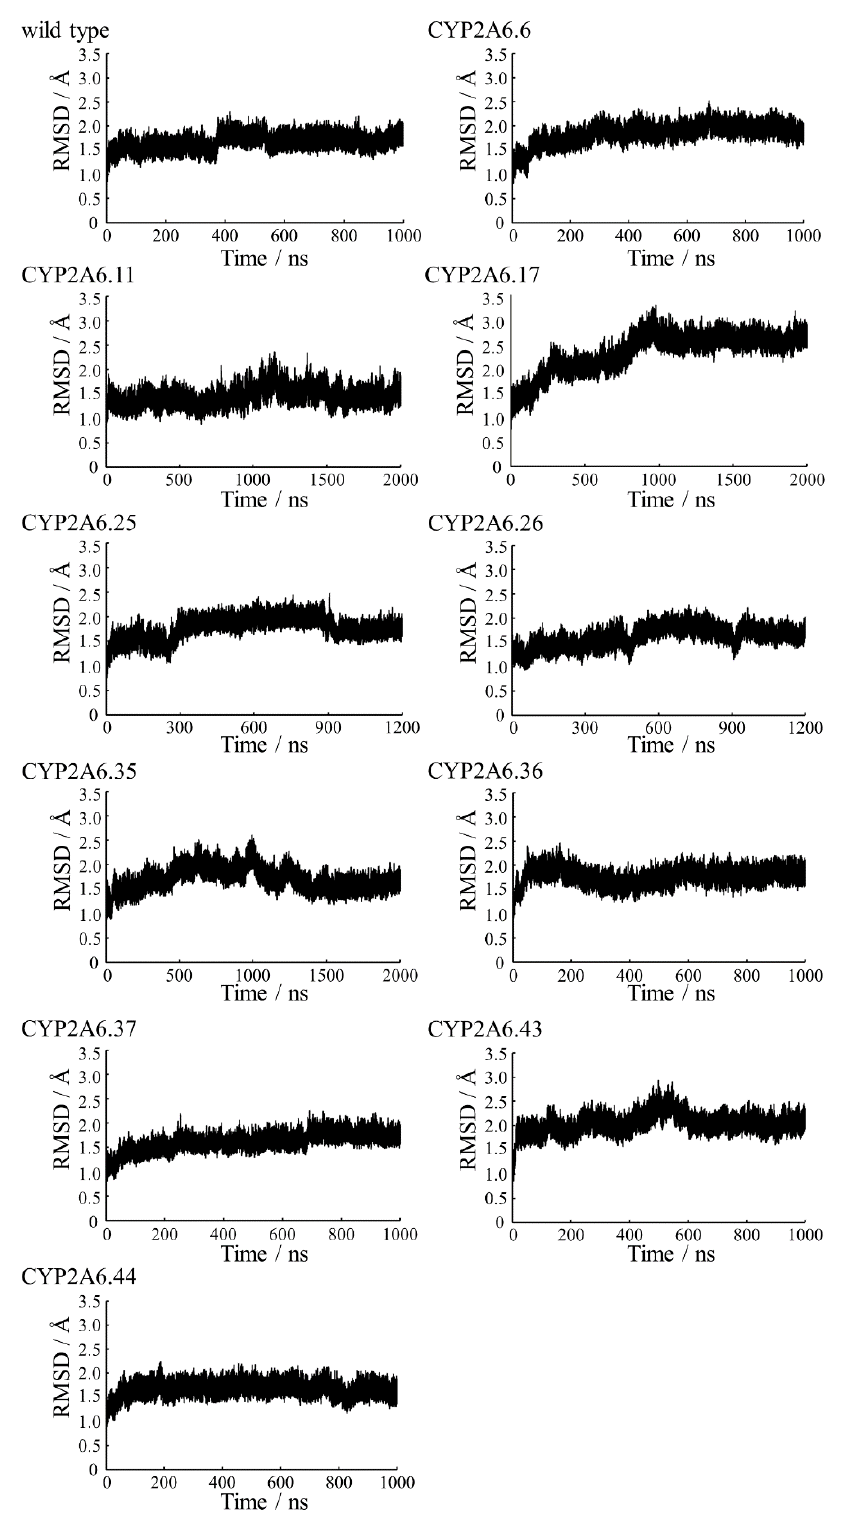
Figure 2. Root mean square deviations (RMSD) plots of the main-chain atoms for CYP2A6 wild type and mutants.